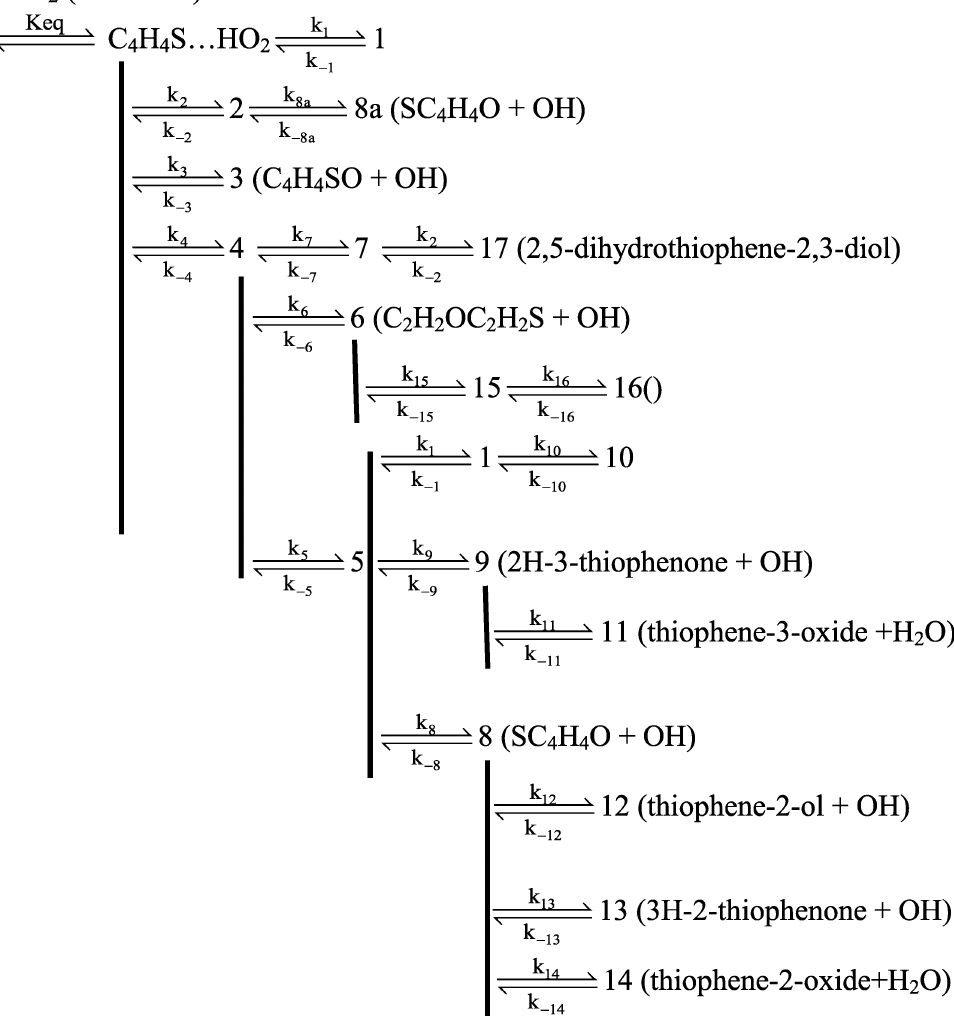
Figure 1. The schematic representation of all the reaction pathways suggested for thiophene plus HO 2